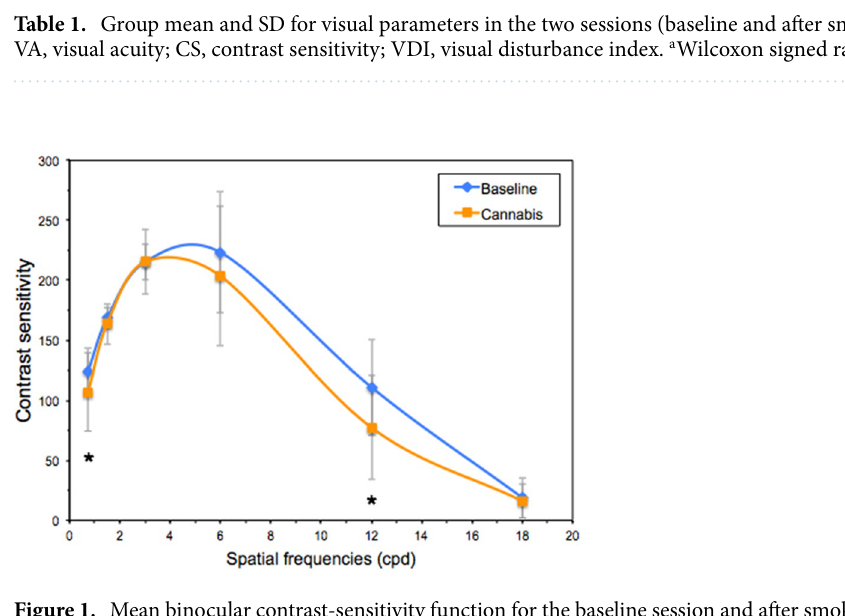
Figure 1. Mean binocular contrast-sensitivity function for the baseline session and after smoking cannabis. Error bars indicate the SD and * is used when p < 0.05 (Wilcoxon-signed ranks test). cpd, cycles per degree.